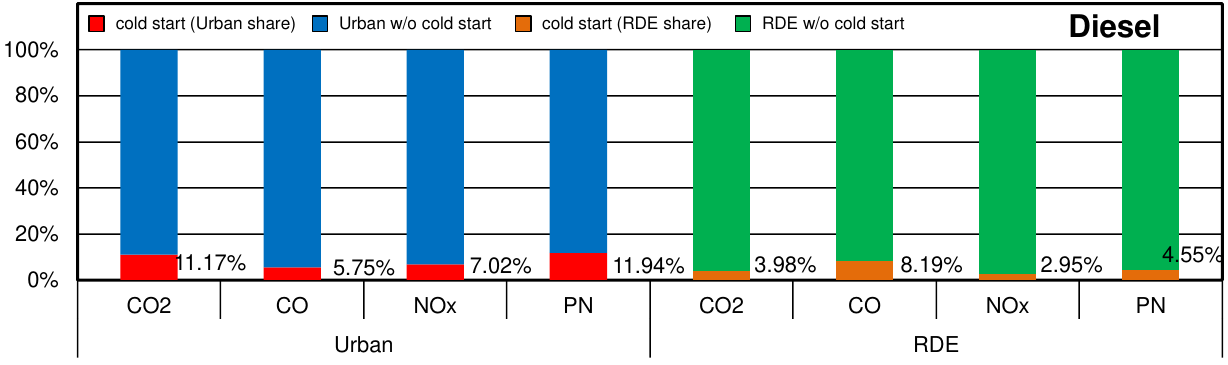
Fig. 15. The share of emissions exhaust compounds during the cold start (300 s) in relation to the urban part of RDE test and the entire RDE test for diesel